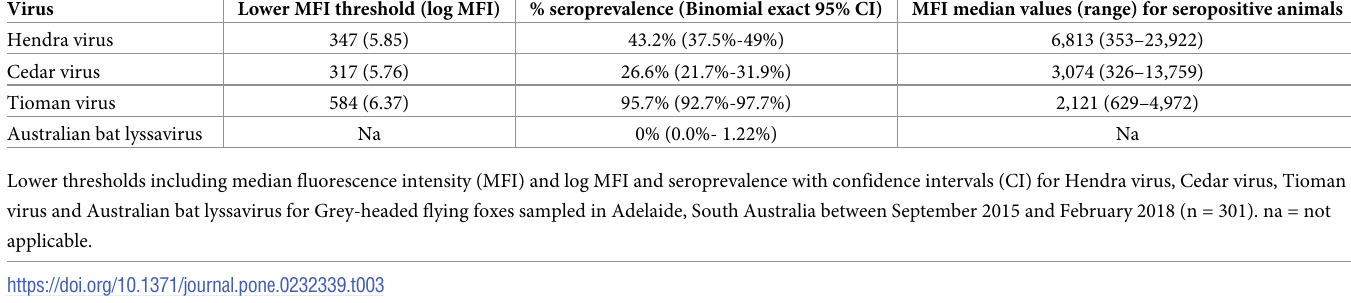
Table 3. Lower threshold MFI scores with corresponding % seroprevalence.